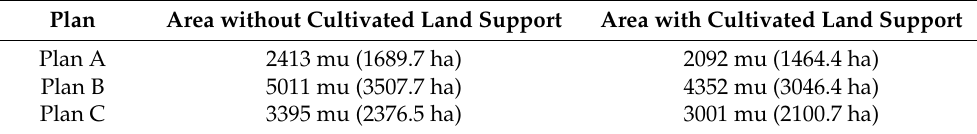
Table 7. Extraction results with cultivated land support in the study